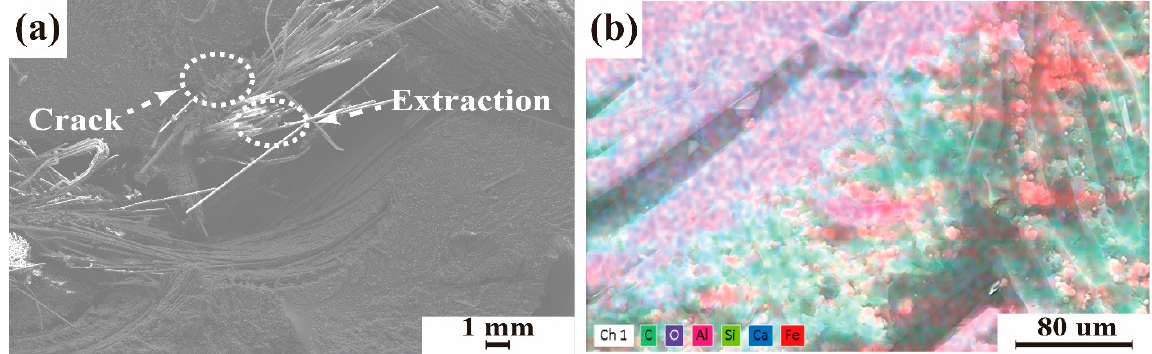
Figure 9. SEM of the fracture surface. ( a ) Microscopic morphology of fracture surface; ( b ) energy spectrum of the fracture surface.